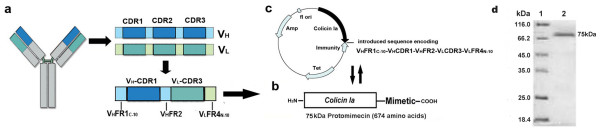
Schematic diagram for the process of constructing the small antibody and the fusion peptide. (a) The small antibody (the mimetic moiety) was composed of VHFR1C-10-VHCDR1-VHFR2-VLCDR3-VLFR4N-10. (b, c) The mimetic was conjugated to the C-terminal of wild-type colicin Ia to construct the conjugated peptide, named protomimecin (PMN). (d) The 15% SDS- PAGE migration map of the fusion peptide PMN.